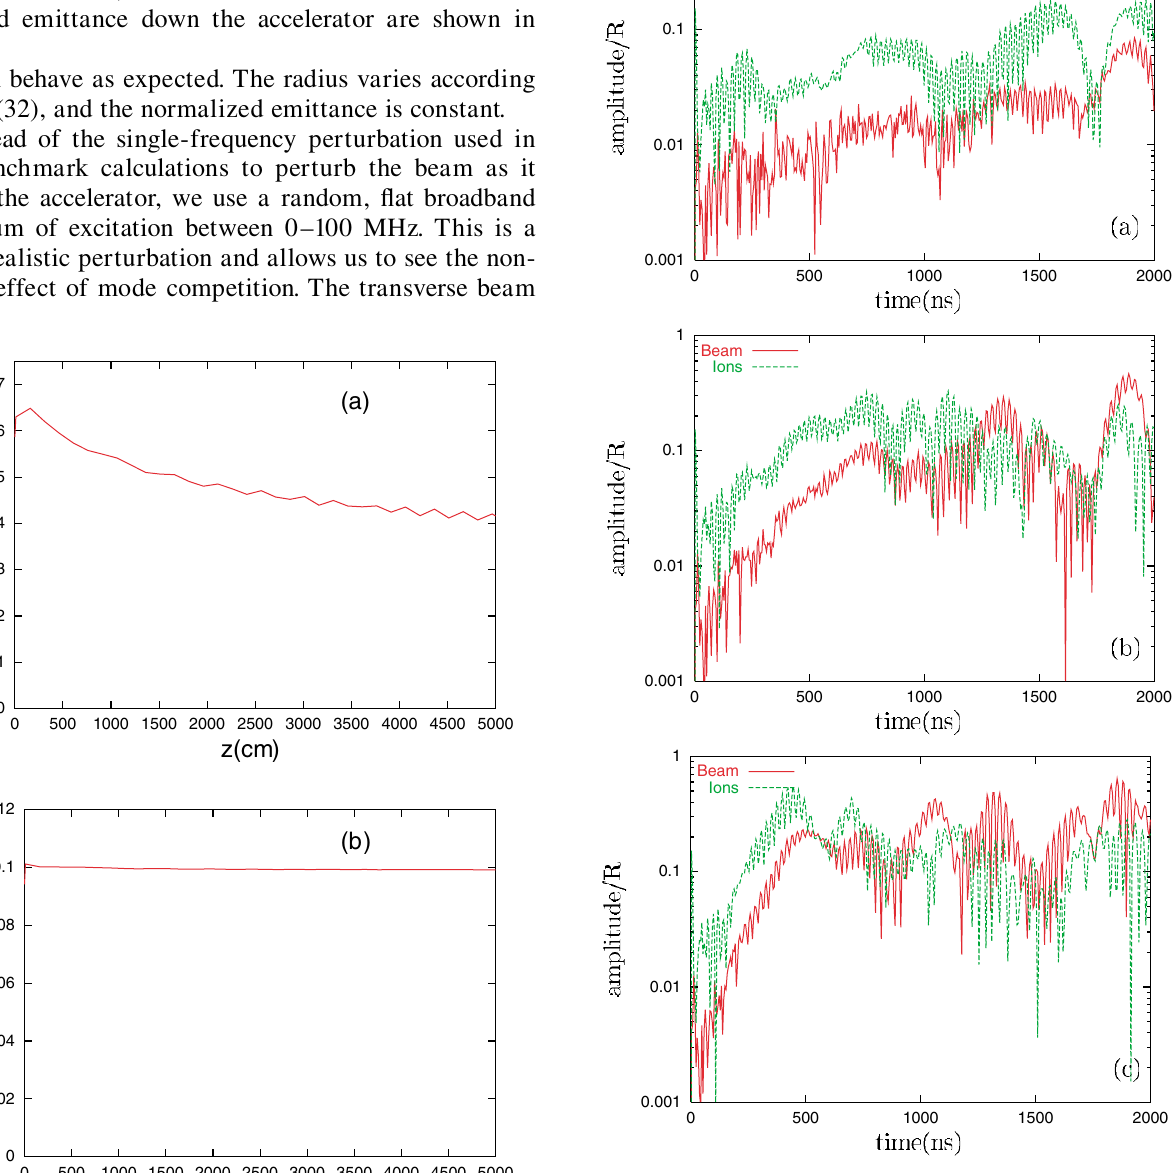
FIG. 9. (Color) Comparison of beam and channel centroids at the end of the 50-m accelerator from LSP calculations, at pressures of (a) 10 (cid:1) 7 torr , (b) 3 (cid:3) 10 (cid:1) 7 torr , and (c) 6 (cid:3) 10 (cid:1) 7 torr